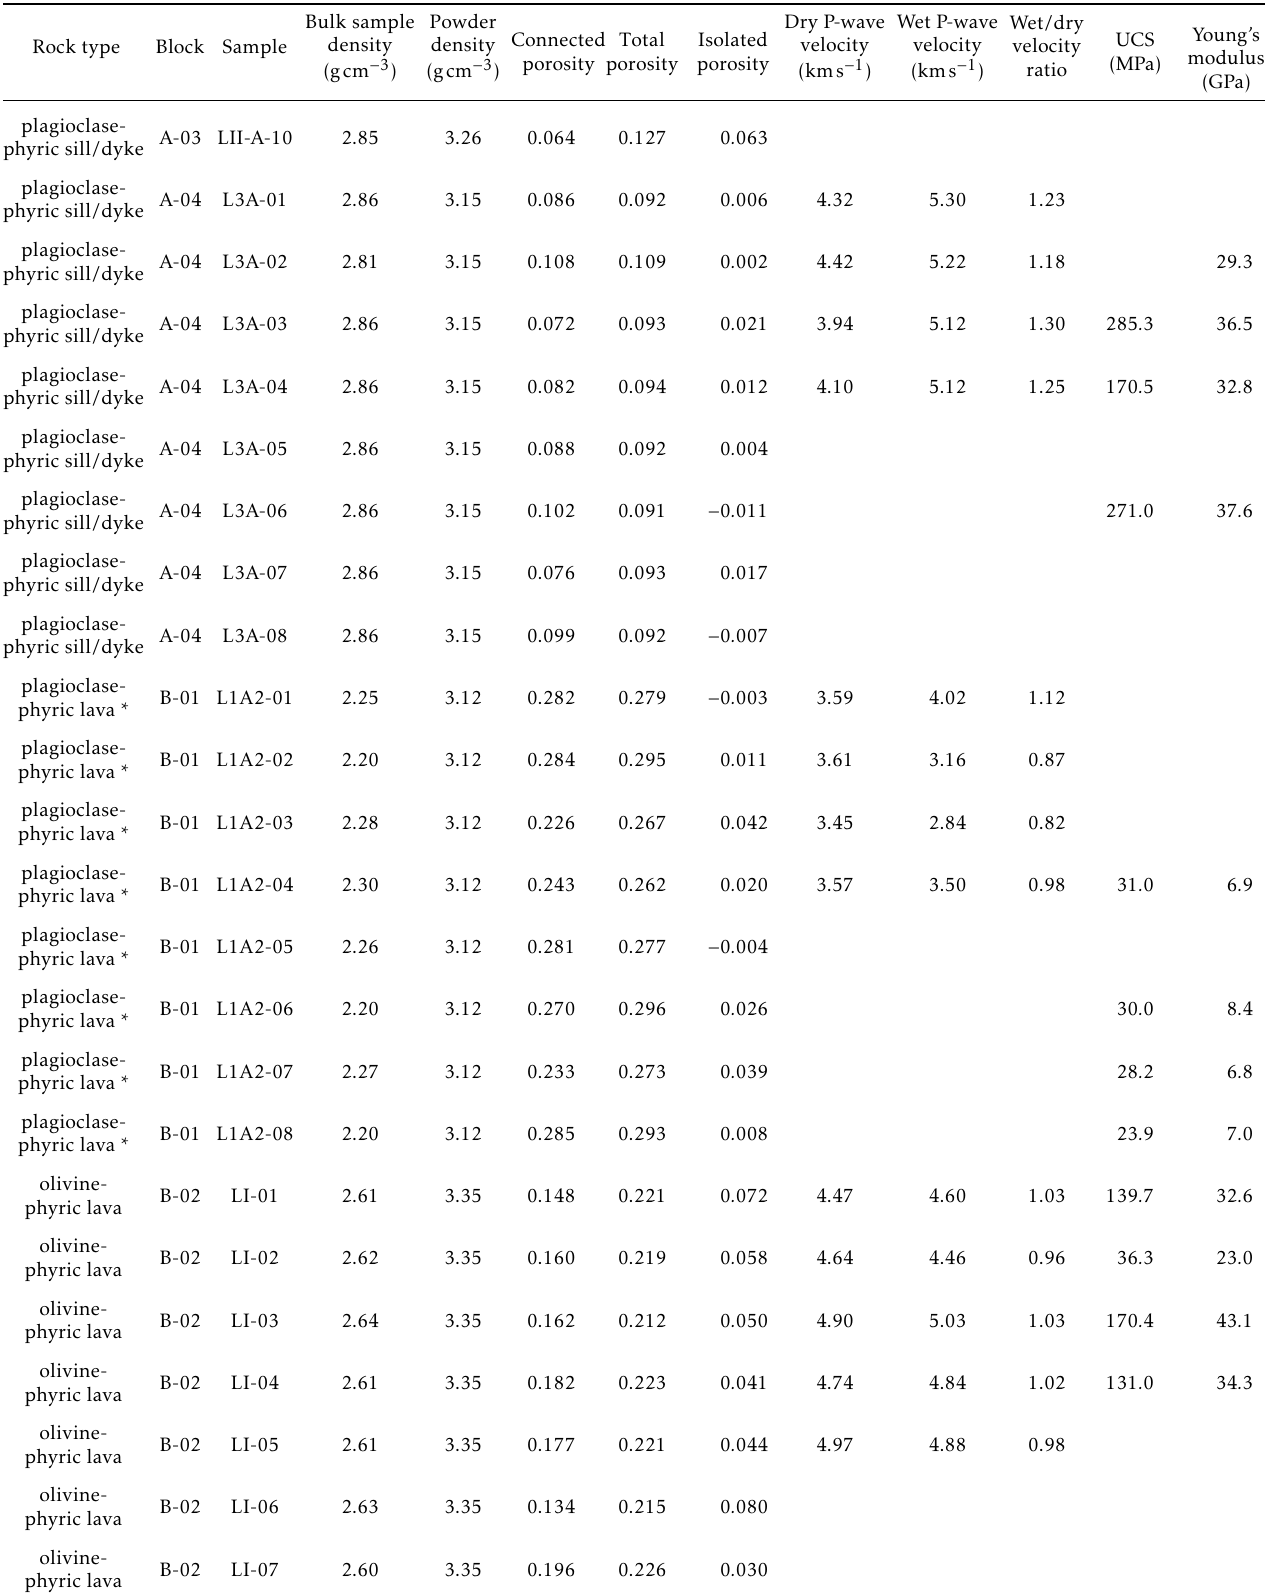
Table A1 [cont.]: Summary of the rock physical property measurements for the samples collected from Piton de la Fournaise (France) for this study. UCS – uniaxial compressive strength. *Presence of zeolites in some of the vesicles. [Continued next